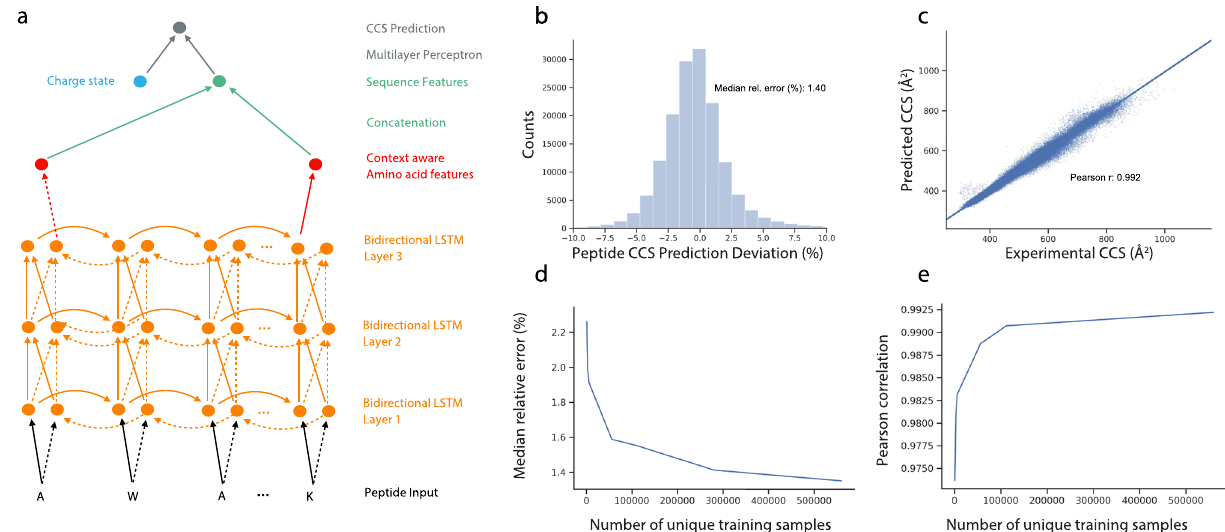
Fig. 4 Deep learning peptide CCS values. a Architecture of the neural network. Bi-directional long short-term model (LSTM): (i) amino acid sequence input, (ii) vectorization of amino acid information for processing, (iii) bi-directional LSTM layers, (iv) reduction to fi xed length peptide feature vector by concatenating the last output neurons of both directional LSTMs, and (v) CCS prediction. b Relative deviation of predicted CCS values from an independent experimental validation dataset of synthetic peptides from the ProteomeTools project. c Correlation of predicted versus experimental CCS values ( n = 155,004). d Dependence of the median relative error on training dataset size. e Same for Pearson correlation coef fi cient. Source Data are provided as a Source Data fi